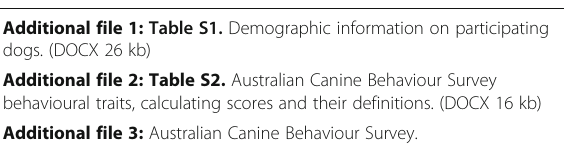
Additional file 1: Table S1. Demographic information on participating dogs. (DOCX 26 kb) Additional file 2: Table S2. Australian Canine Behaviour Survey behavioural traits, calculating scores and their definitions. (DOCX 16 kb) Additional file 3: Australian Canine Behaviour